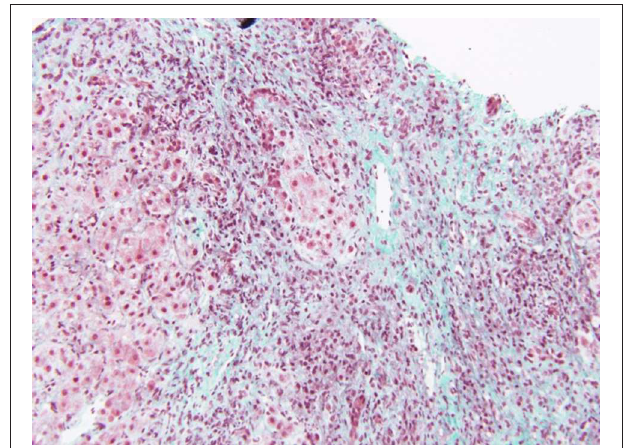
FIGURE 1 | Centrolobular inflammation and fibrosis in a patient with acute presentation of AIH. Trichrome staining showing fibrosis around the central vein and lymphocytic inflammation. Bridging necrosis is also present, between the central vein and a portal tract. Disorganization of the lobular structure is